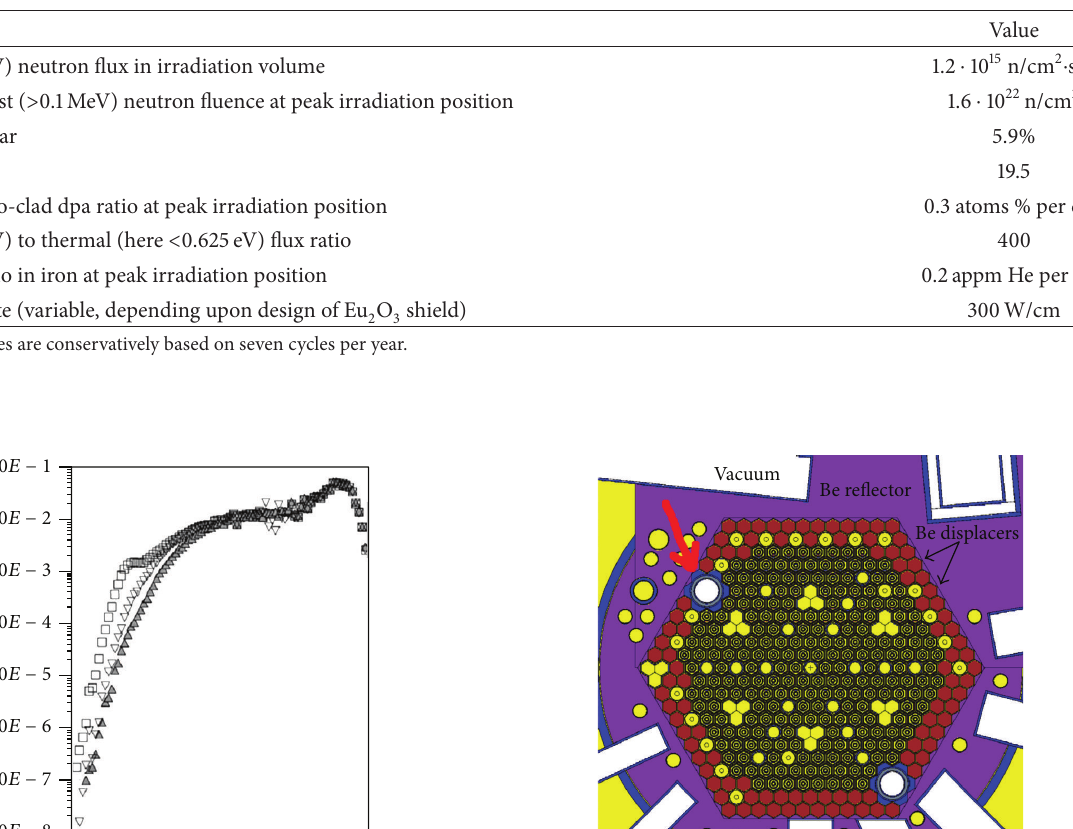
Table 6: HFIR irradiation parameters for proposed tripin concept [23].